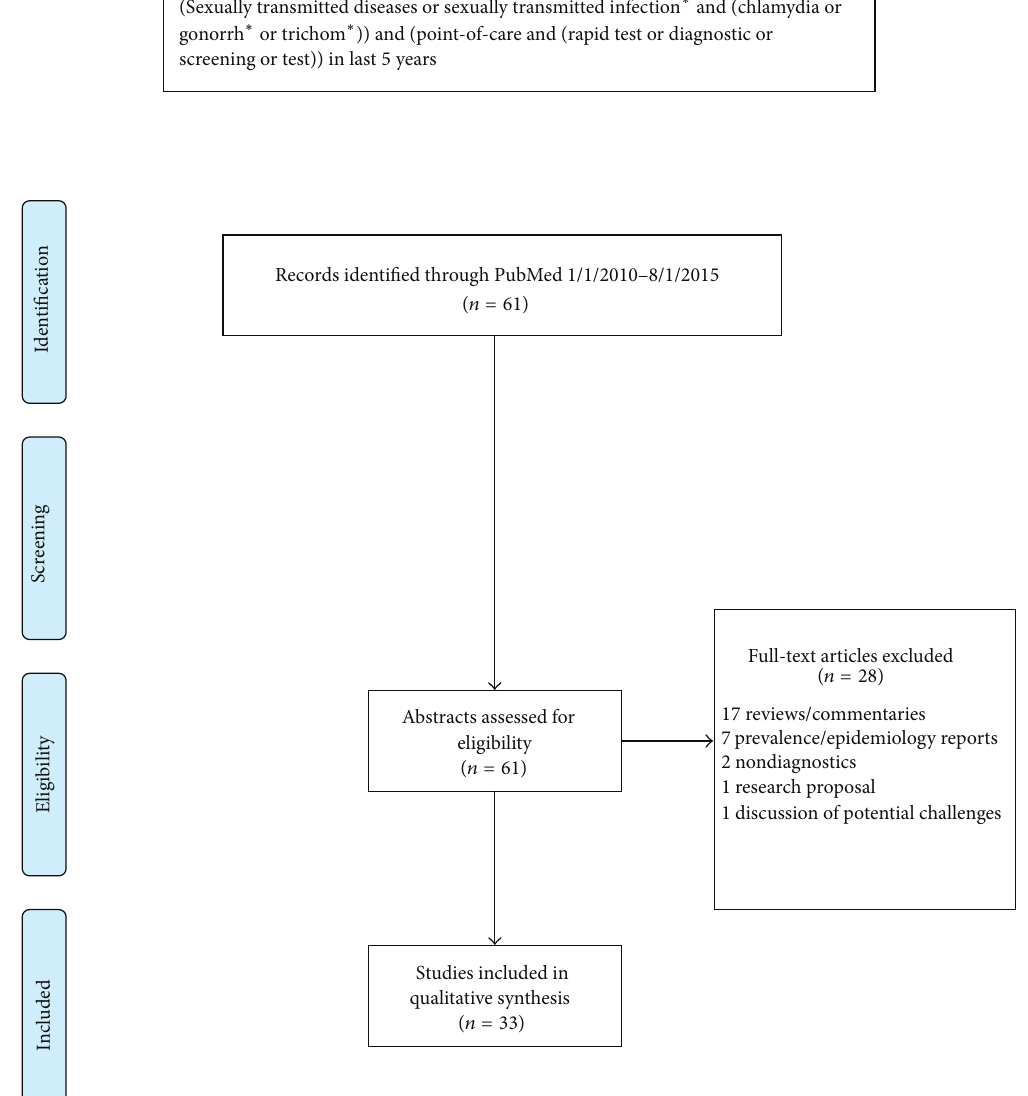
Figure 1: PRISMA flow diagram of publications searched. ∗ refers to the search function of including all words which have the same beginning as the starred word and can have any ending after the star. For example: “gonorrh ∗ ” will search for “gonorrhea,” “gonorrhoea,” and